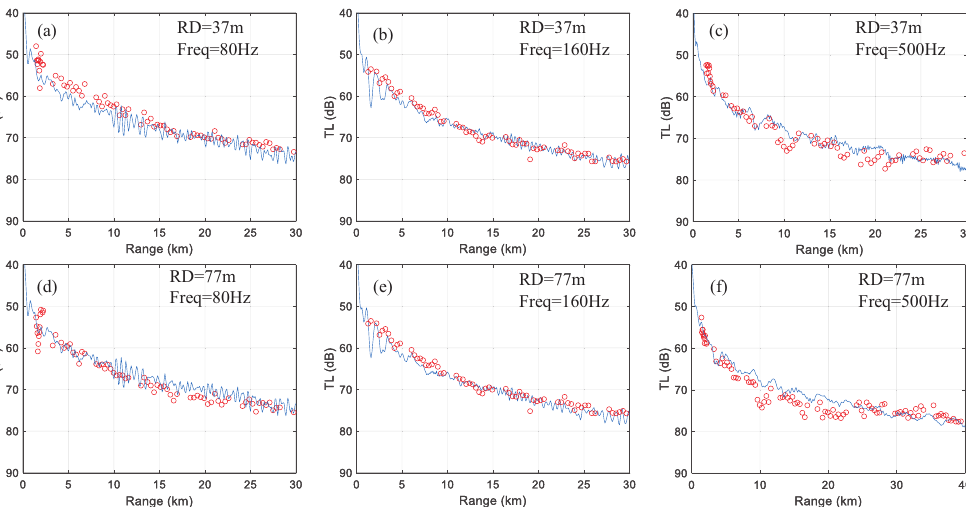
Figure 9. Comparison of TL different frequencies and received depths. The experimental TL is labeled as red circles and the predicted TL is shown by a blue line. ( a ) RD = 37 m, Freq = 80 Hz. ( b ) RD = 37 m, Freq = 160 Hz. ( c ) RD = 37 m, Freq = 500 Hz. ( d ) RD = 77 m, Freq = 80 Hz. ( e ) RD = 77 m, Freq = 160 Hz. ( f ) RD = 77 m, Freq = 500